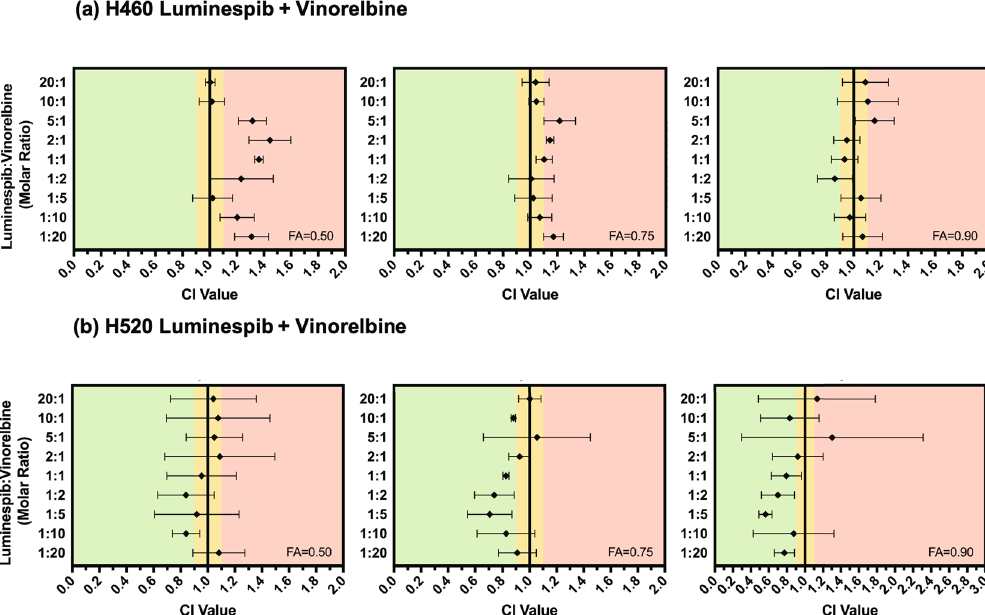
Figure 5. CI values for H460 ( a ) and H520 ( b ) cells treated with various molar ratios of LUM + VRL at FA = 0.50, 0.75, and 0.90. Data are presented as mean and SD (n ≥ 3). CI values < 0.90 indicate that the two drugs act synergistically (shown in green) while CI values of 0.90–1.10 indicate an additive effect (shown in yellow), and CI values > 1.10 indicate that the two drugs act antagonistically (shown in red). The combination was found to be additive and antagonistic in H460 cells, while most ratios were additive and synergistic in H520